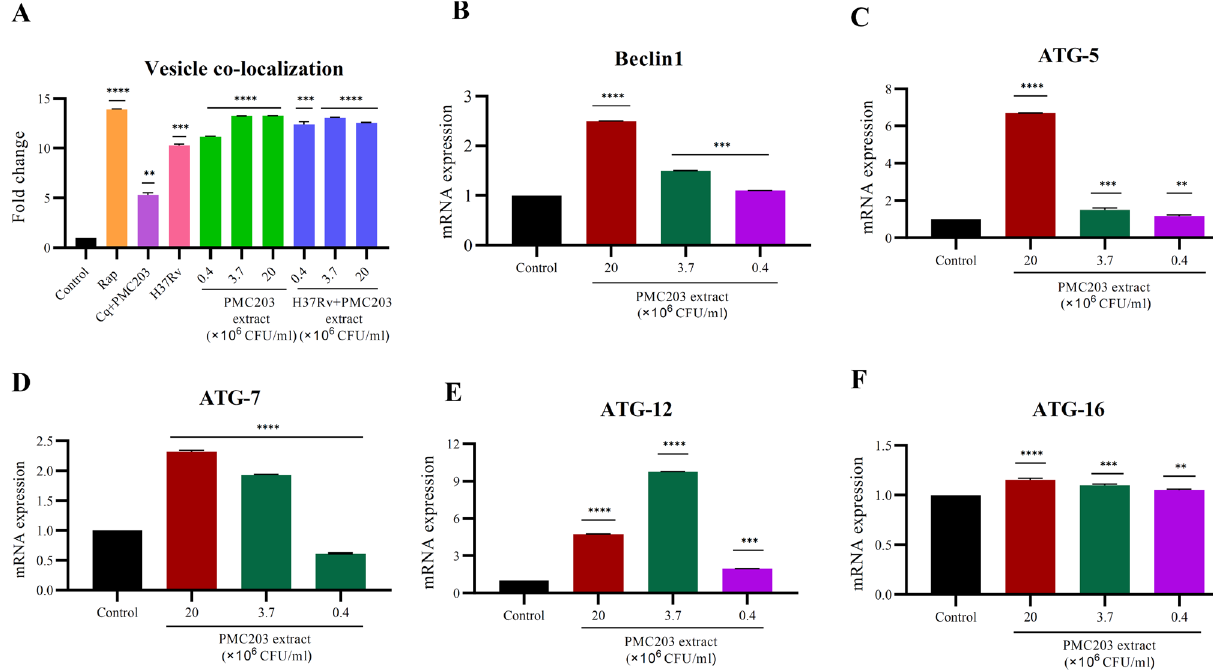
Figure 8. Induction of autophagy by PMC203. ( A ) Raw 264.7 cell lines were treated with the cell extract of PMC203 at three different concentrations and then vesicle co-localization with LC3 signal was measured using autophagy detection kit by fluorescence microplate reader. ( B – F ) The mRNA expressions of Beclin1 pathway, and autophagy gene complex was detected by quantitative Real-Time PCR. These experiments were performed three times in triplicate. Values are expressed as mean values and standard deviations. *Statistical significance with controls were determined using Graph Pad Prism 9.1.1, one-way ANOVA (*p < 0.05, **p < 0.01, ***p < 0.001, ****p < 0.0001). Rap rapamycin, Cq